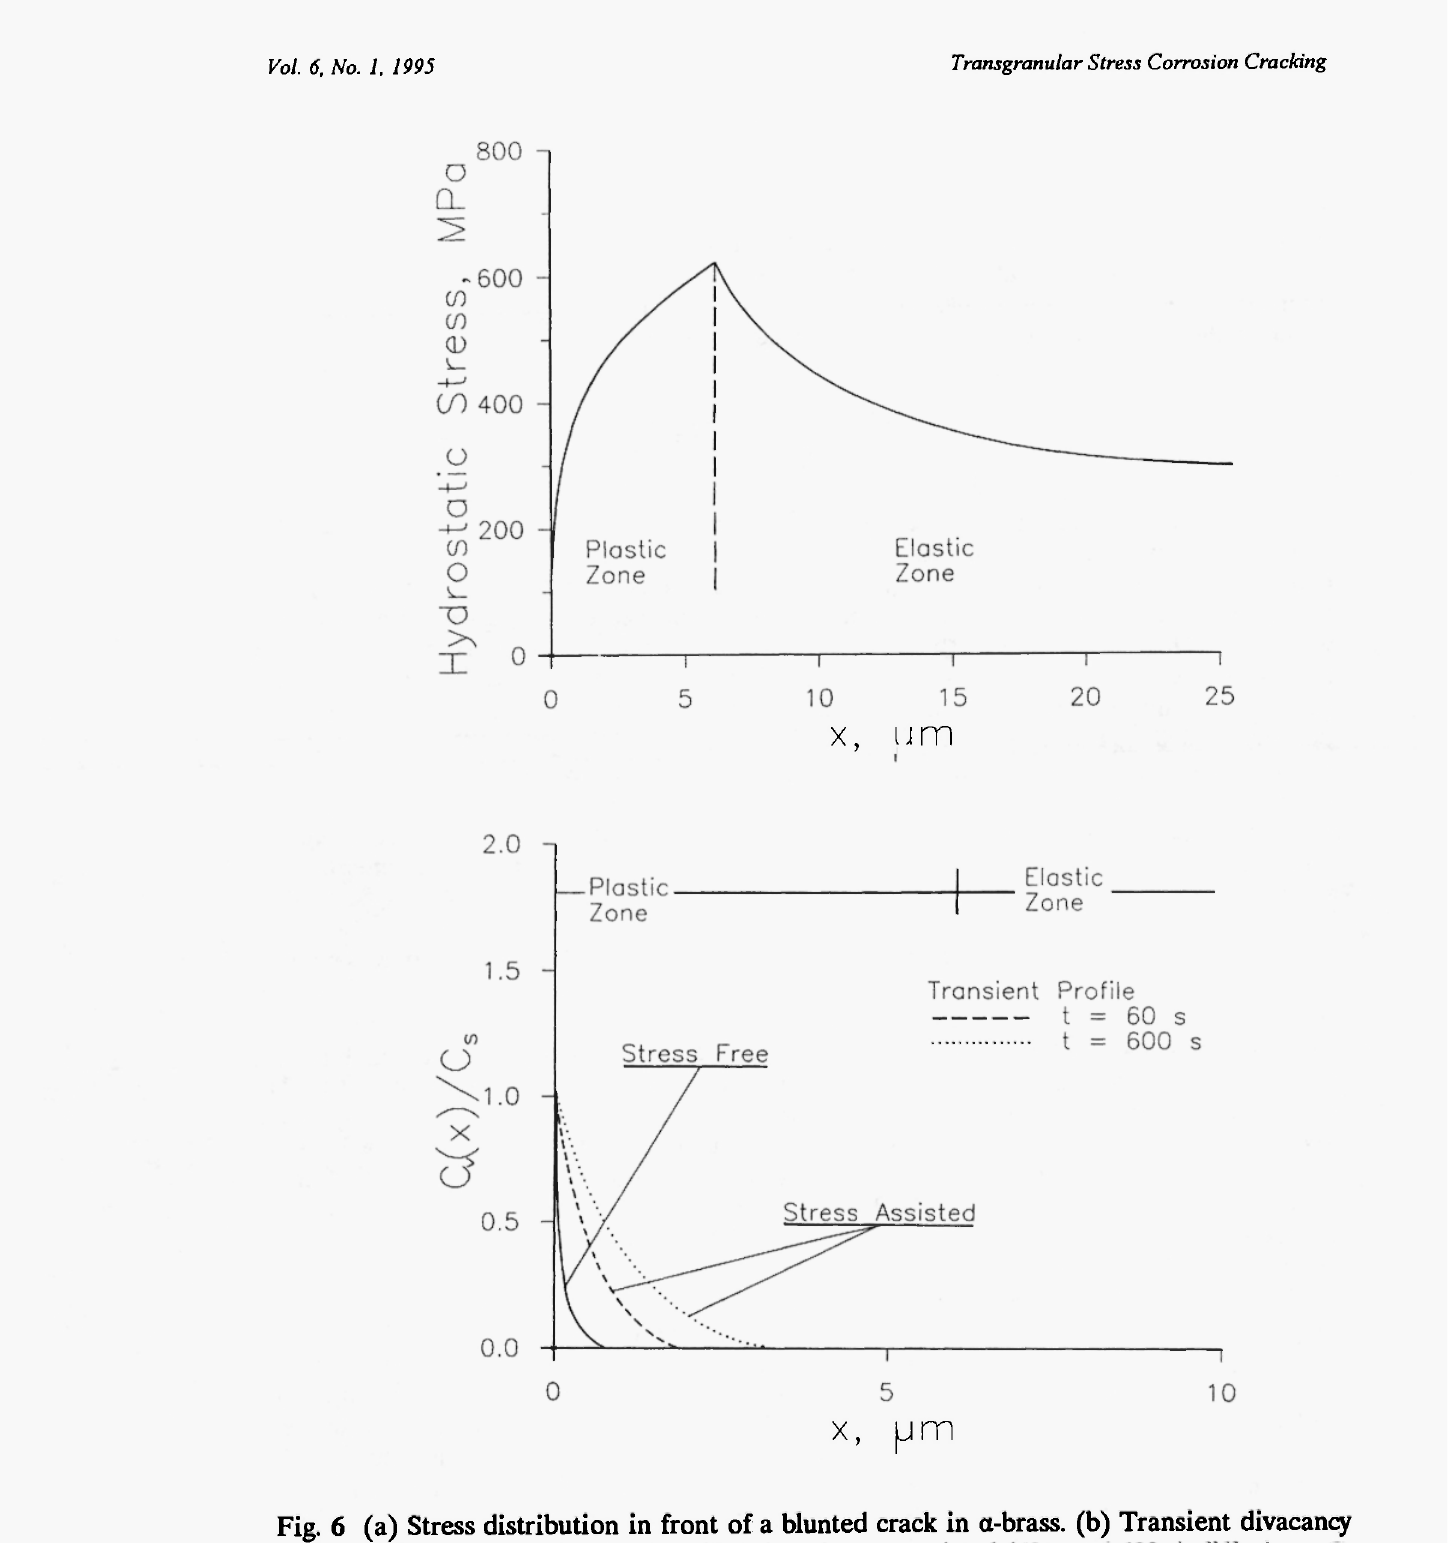
Fig. 6 (a) Stress distribution in front of a blunted crack in α-brass, (b) Transient divacancy concentration profiles of stress free (600 s) and stress-assisted (60 s and 600 s) diffusion. C s denotes the divacancy concentration at the